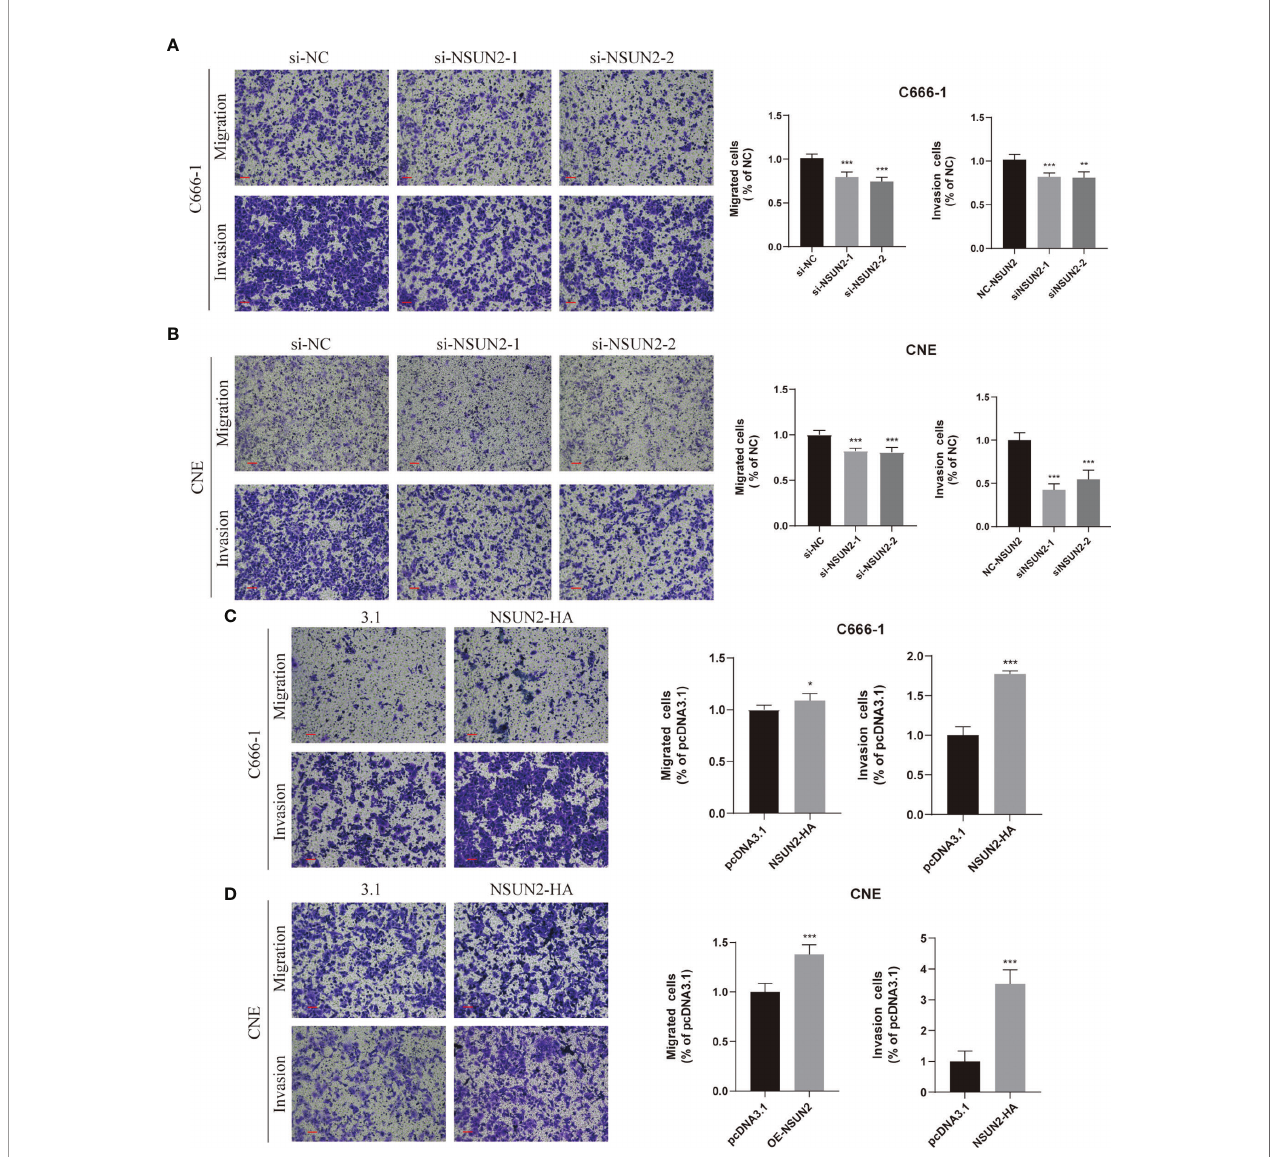
FIGURE 4 | NSUN2 promotes the migration and invasion of NPC cells. Representative images of Transwell assays with C666-1 and CNE cells under NSUN2 knockdown (A, B) or overexpression (C, D) . The numbers of migrating and invading cells are presented in the right panel. Scale bar, 100 m m. * P < 0.05, ** P < 0.01, and *** P <